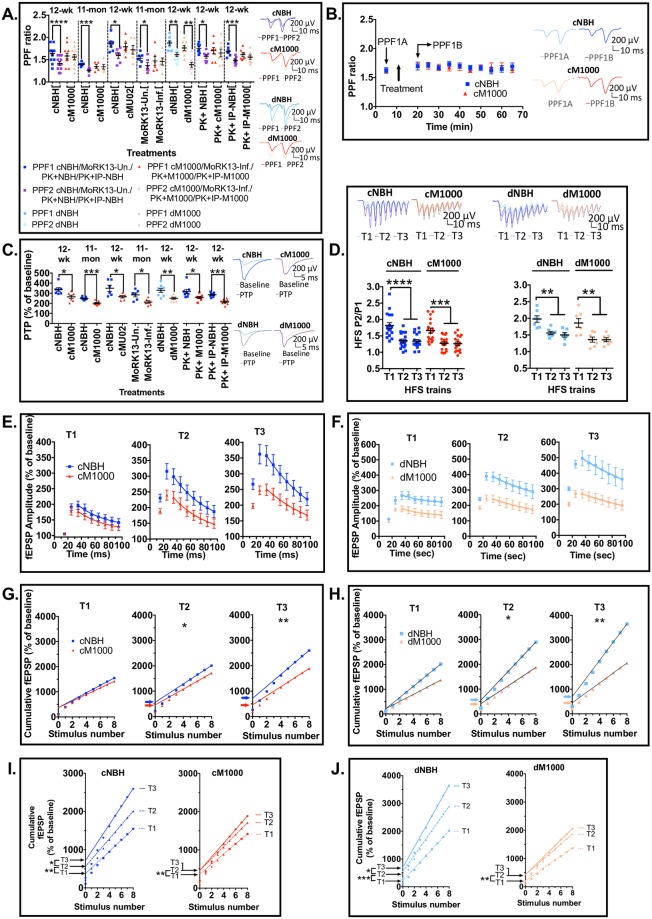
Prion acute synaptotoxicity demonstrates enhanced pre-synaptic vulnerability in WT hippocampal slices.(A) Normal PPF ratio reductions (the ratio becomes significantly reduced in PPF2 relative to PPF1) were obtained in slices after LTP induction and exposure to all negative controls: cNBH (for cM1000 treatments in 12-week old [p<0001] and 11-month old mice [p = 0.0008]; cMU02 treatment [p = 0.0104]); dNBH (p = 0.0017); PK+NBH (p = 0.0182); PK+IP-NBH (p = 0.0002); and MoRK13-Un (p = 0.0170). Conversely, PPF ratio in slices treated with cM1000 (both in 12-week and 11-month old mice), cMU02, MoRK13-Inf, PK+M1000, and PK+IP-M1000 was not reduced in PPF2 relative to PPF1, showing poor Pr associated with the LTP disruption. The PPF ratio was normal in dM1000 (p = 0.0013) concomitant with the recovery of LTP. (B) Treatment of slices with cM1000 without inducing LTP expression did not affect PPF ratios relative to slices treated with cNBH. (C) Relative to appropriate negative controls, PTP was significantly disrupted after cM1000 treatment of slices from 12-week-old (p = 0.0144) and 11-month-old (p = 0.0006) mice. Similar PTP disruption was obtained following treatment with cMU02 (p = 0.0391), MoRK13-Inf (p = 0.0172), dM1000 (p = 0.0062), PK+M1000 (p = 0.0359), and PK+IP-M1000 (p<0.0001). (D) The Pr during the HFS trains was normal in both cM1000 and dM1000 relative to cNBH and dNBH controls, respectively where the Pr became significantly increased (determined by the P1 to P2 ratio in each train) in T2 and T3 relative to T1. (E & F) Consistent with the normal Pr, the rate of RRP depletion was normal across three HFS trains in both cM1000 (E) and dM1000 (F), where the time constant of decay between P3 and P9 in each train was not different between cNBH and cM1000, as well as between dNBH and dM1000. (G & H) The size of RRP (determined by the Y-intercepts of the linear fit of the last four pulses of HFS) became significantly diminished at T3 in cM1000 (G) and dM1000 (H) relative to cNBH (G) and dNBH (H). (I & J) This reduction in RRP size was caused by a significant impairment of the RRP replenishment (indicated by the increase in the RRP size between trains) to refill the RRP at T3 in both cM1000 (I) and dM1000 (J) compared with cNBH (I) and dNBH (J). The reduction in RRP size contributed directly to the impairment of PTP. (A-D) Examples of raw fEPSP traces are provided as insets. Data are presented as ± SEM. *p<0.05, **p<0.01, ***p<0.001, ****p<0.0001.